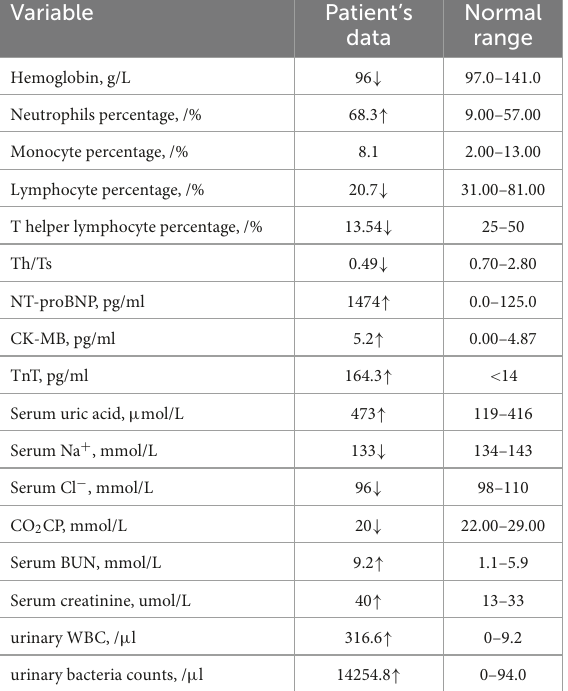
TABLE 1 Laboratory data of the patient with HUPRA syndrome.